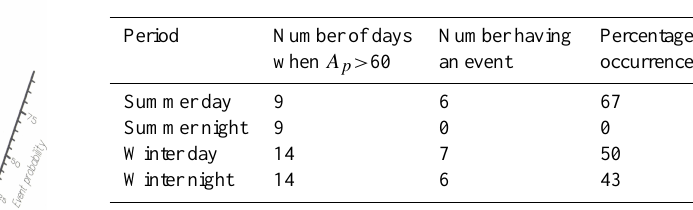
Table 1. Statistics of event occurrence at high activity, A p > 60. The daily and seasonal periods are those defined in Figs. 1 and 2.